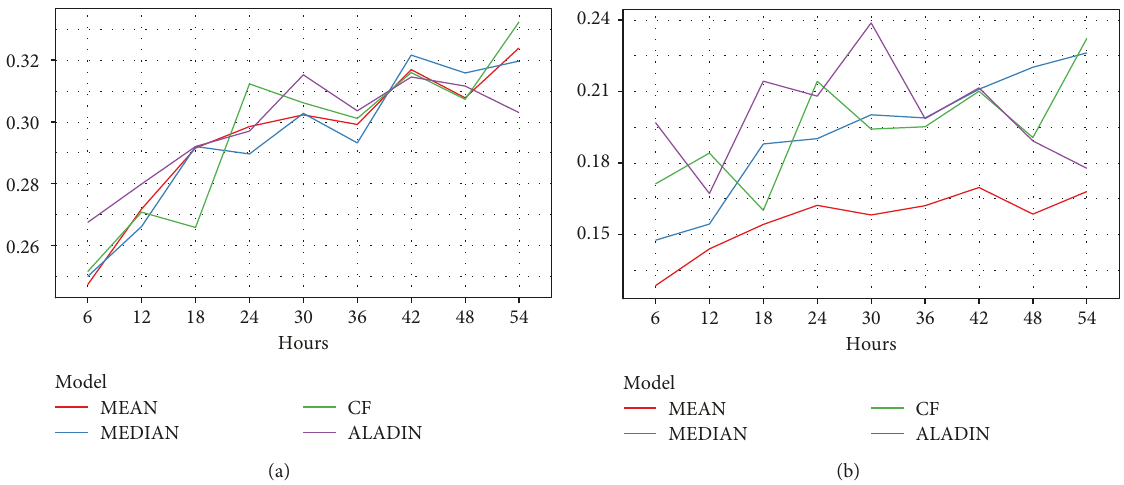
Figure 5: Ensemble skill scores using ALADIN (purple), MEAN (red), MEDIAN (blue), and CF (green) as reference forecasts. RPSS (a) and BSS (b) show positive ensemble skill as a function of lead time.